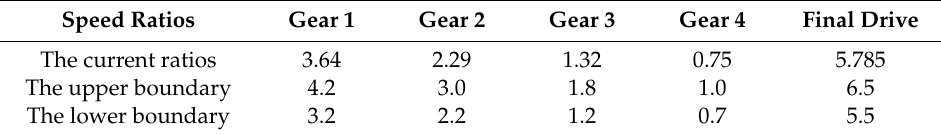
Table 2. The boundaries of the optimization parameters.